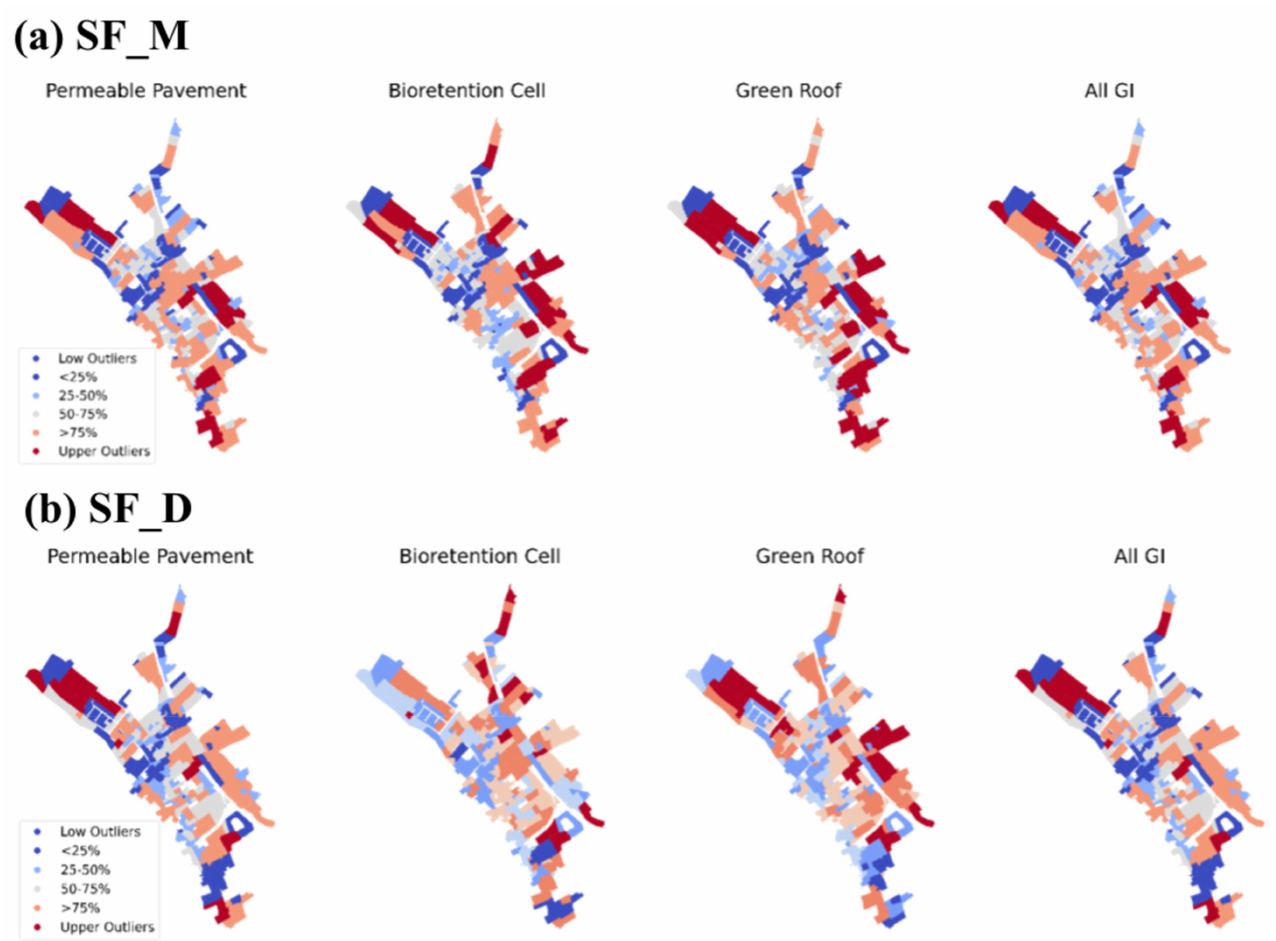
Figure 6. Box map for the sensitivity to location of GI impact on resilience enhancement. Level of service loss measured: sewer flooding. ( a ) Sewer flooding magnitude (SF_M). ( b ) Sewer flooding duration